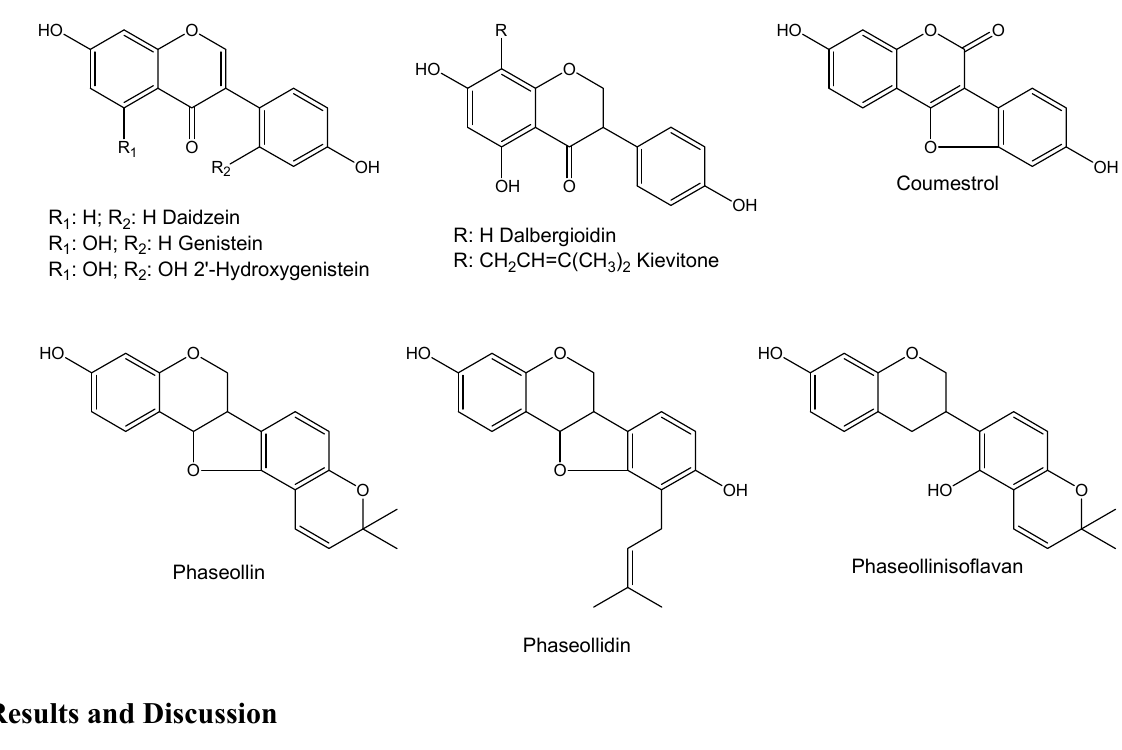
Figure 1. Chemical structures of some phytoalexins in common